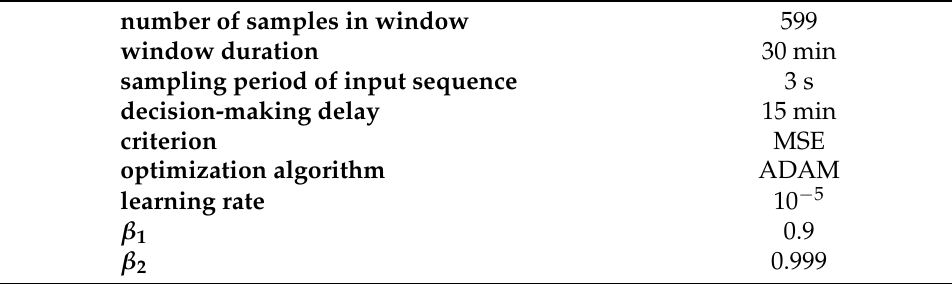
Table 6. Training